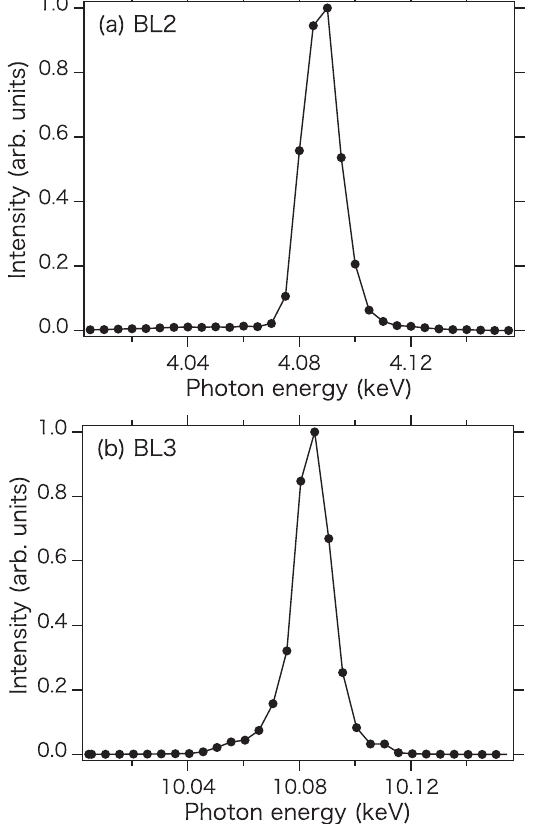
FIG. 11. Averaged laser spectra measured by scanning a monochromator in the multi-beam-line operation combined with the multienergy operation of the accelerator, (a) BL2 and (b) BL3. The electron beam energy of BL2 was 6.3 GeV and that of BL3 was 7.8 GeV. The undulator K-values were 2.85 and 2.1 for BL2 and BL3, respectively. The peak current is 1.2 kA for both beam lines.